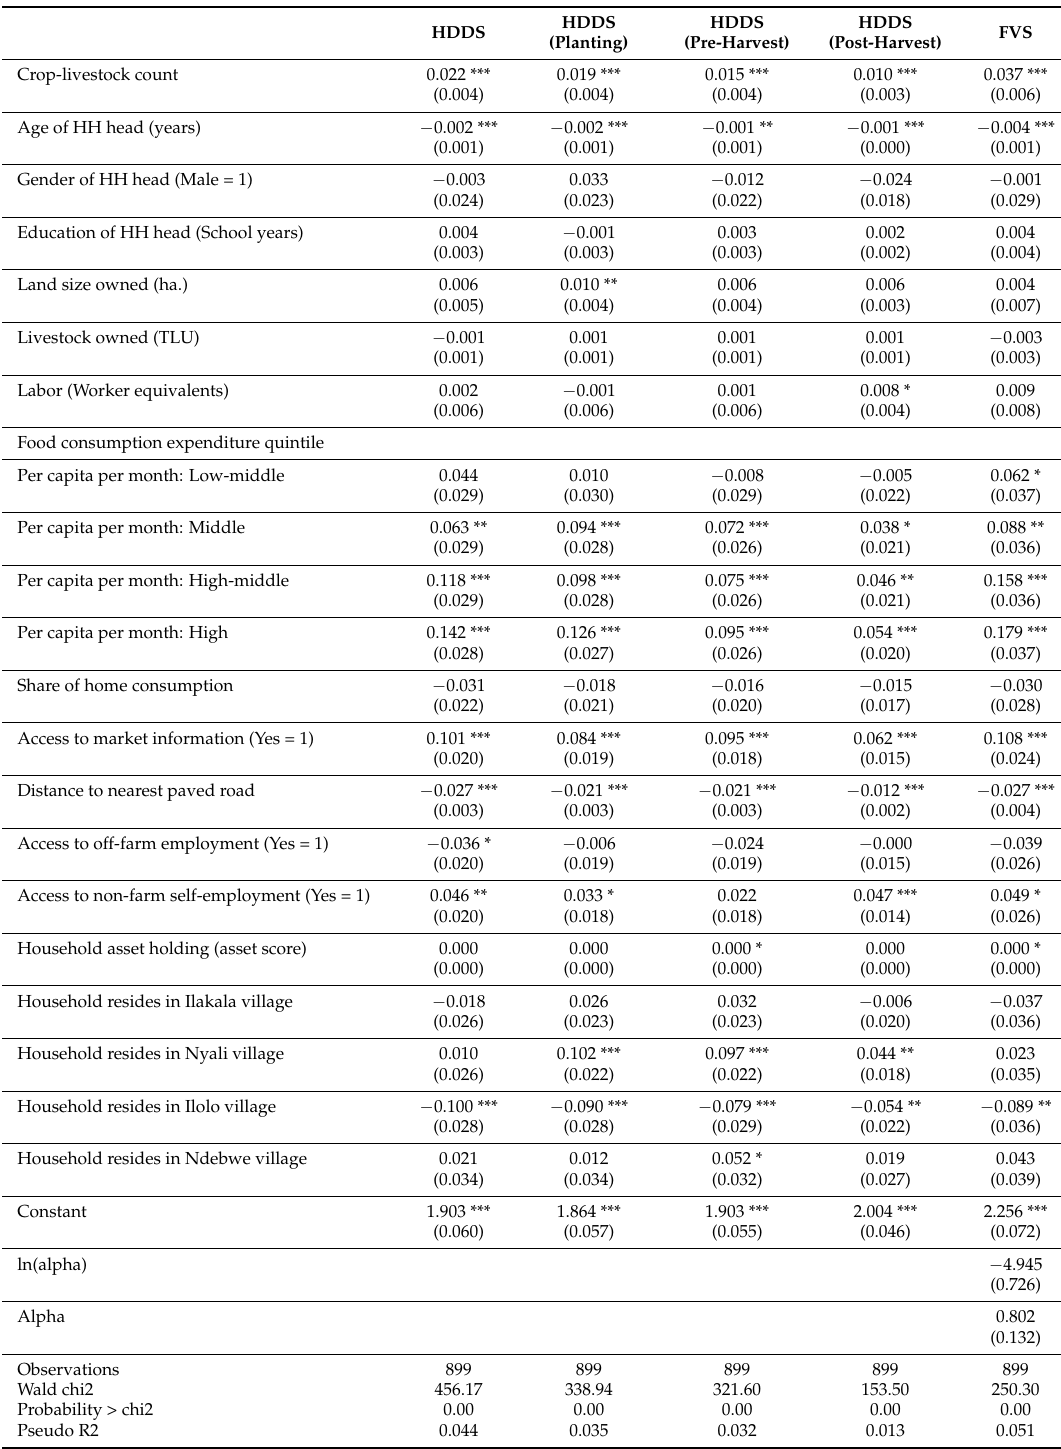
Table 5. Effects of farm production diversity on household food consumption diversity—Pooled sample (Farm production diversity indicator: Crop-livestock